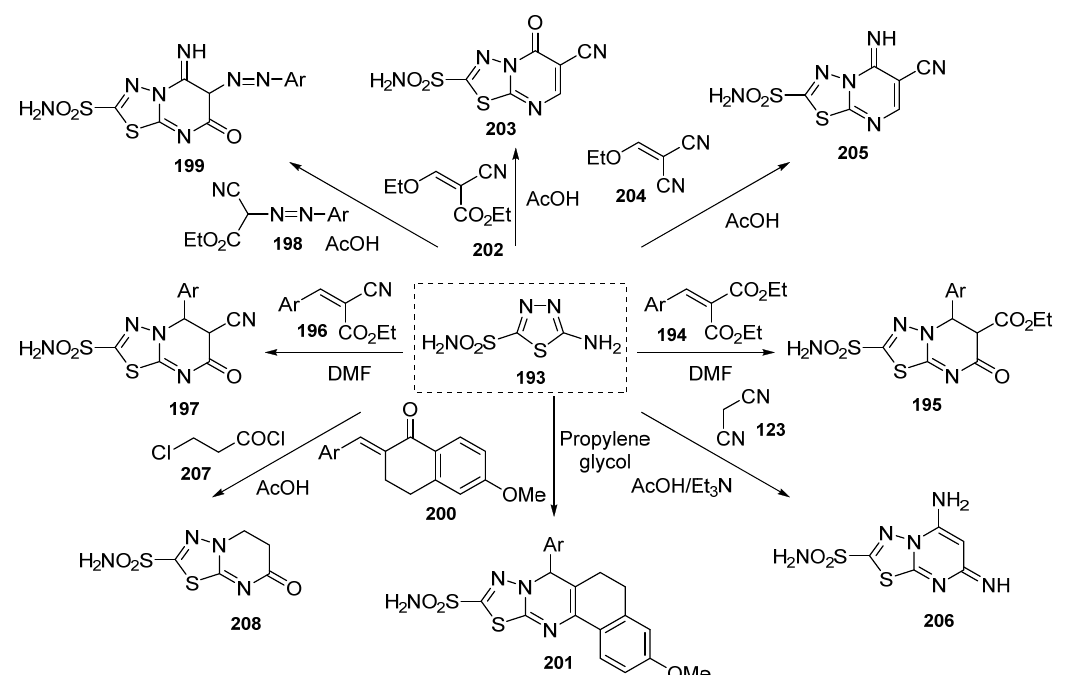
Scheme 82. Synthesis of different series of fused